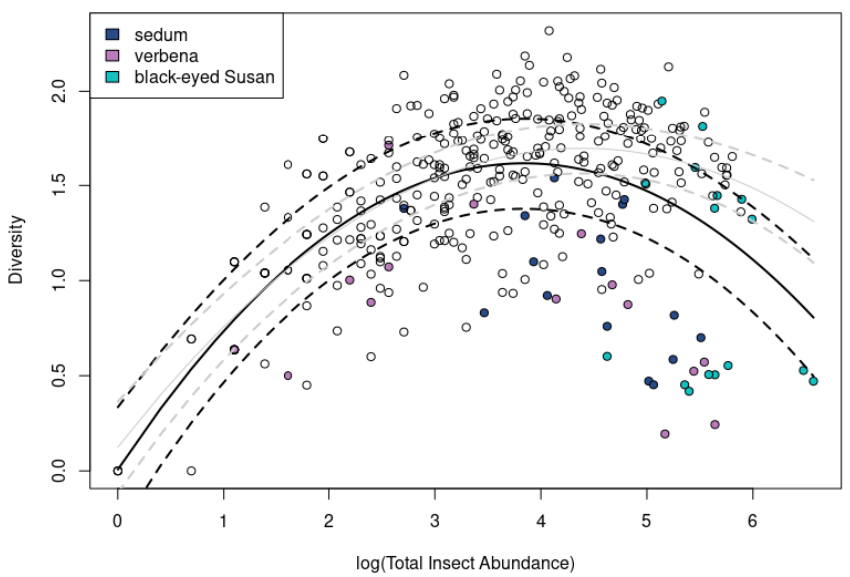
Figure 6. Insect group diversity and insect abundance has a curvilinear relationship across the plants in our study. Each point represents observations per plot per year. The black solid and dashed lines show mean diversity and 95% CI. Black-eyed Susan, sedum, and verbena are highlighted because they were initially suspected to drive the curvilinear relationship; however, the significant relationship was maintained even with their removal (grey solid and grey dashed line show mean diversity and 95% CI).